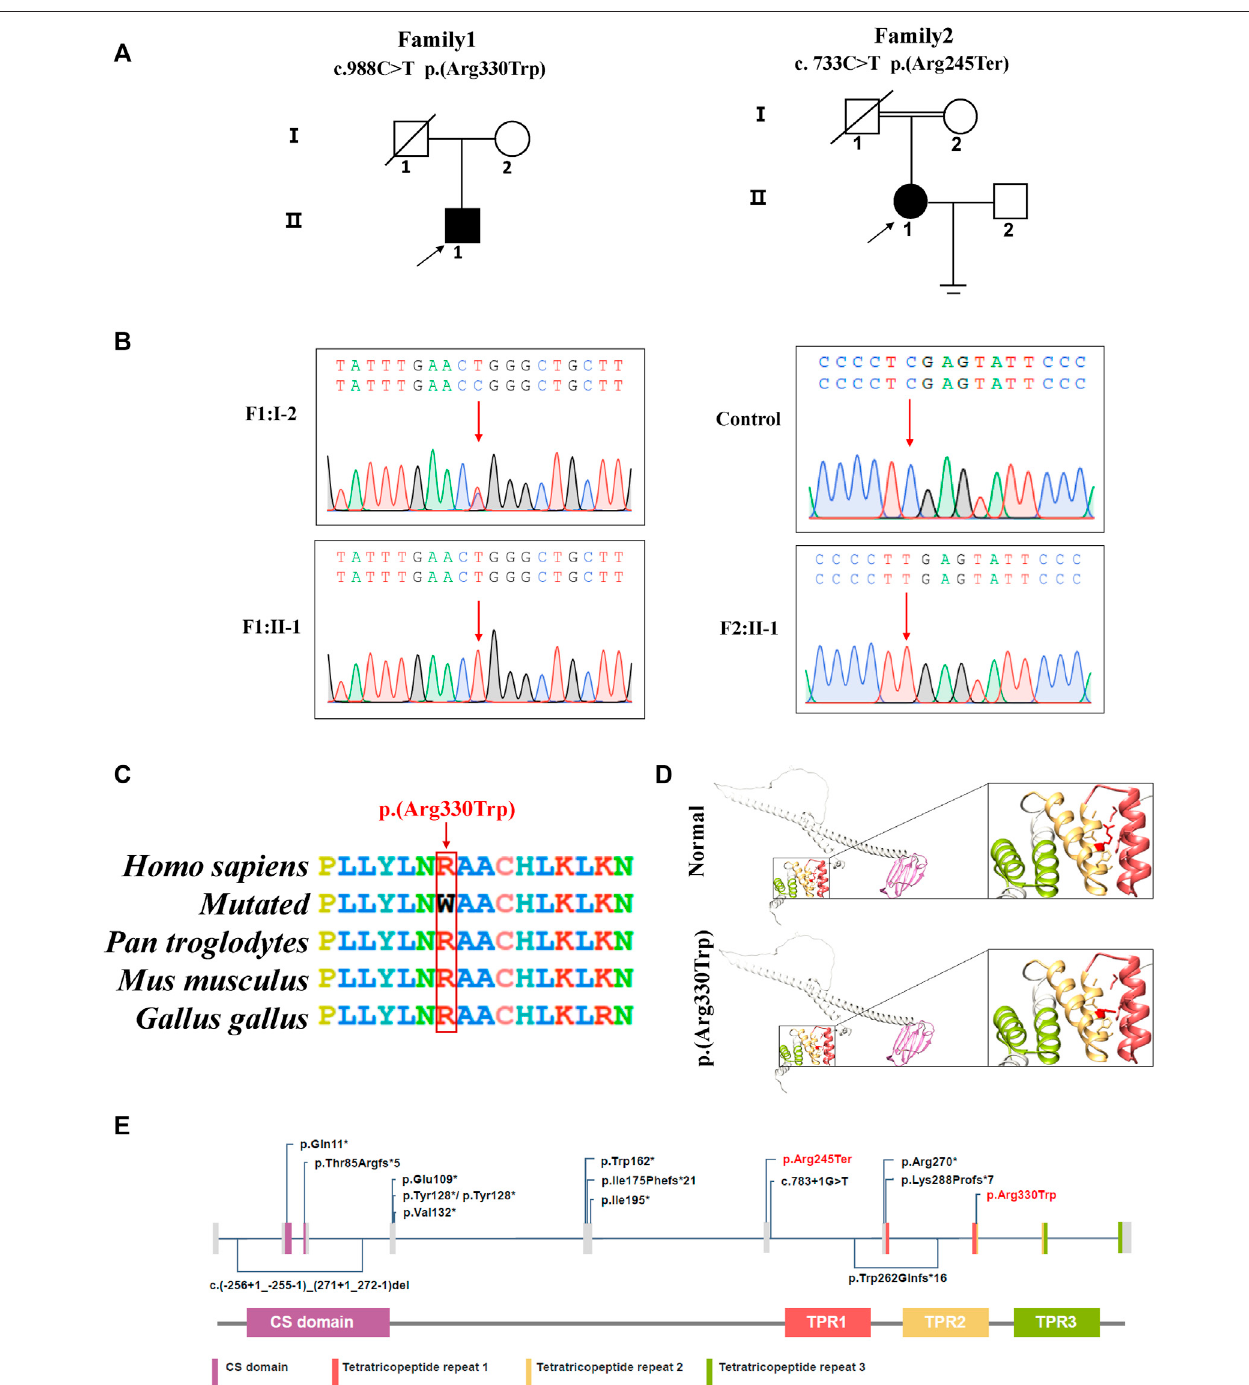
FIGURE 2 | DNAAF4 variants were identi fi ed in two patients with PCD. (A) pedigree analysis of the two patients from two Han Chinese families, where family 2 is a consanguineousfamily.Circlesindicatewomen.Squaresindicatemen.Solidsymbolsindicatepatients.Crossed-outsymbolsmeanthatsubjectshadpassedaway.The arrowsindicatetheprobands. (B) thetwovariantswerevalidatedbySangersequencing.Redarrowsindicatethevariantsites; (C) conservativeanalysisofthemissense variant (C) 988C > T(p.Arg330Trp).Redboxindicatesmutantaminoacidsites. (D) 3DmockstructureofDNAAF4.ThepurpleregionistheCSdomain,whilegreen, yellow, and brick red indicate the three tetratricopeptide repeats, respectively.The variant p.(Arg330Trp) is indicated by red color. (E) DNAAF4 protein structure and the reported disease-causing variants of DNAAF4. Variants reported in this study are highlighted in red.